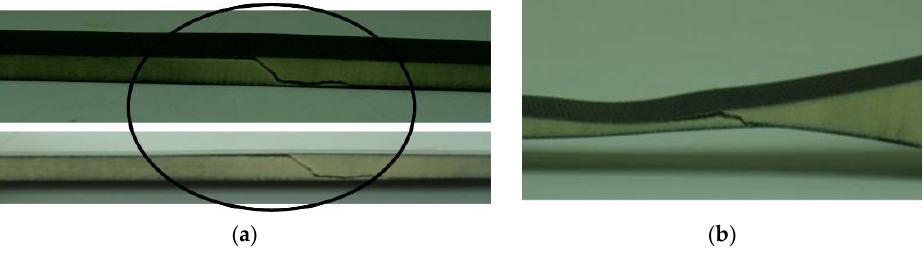
Figure 15. ( a ) Failure found in three-point bending tests; ( b ) failure found in vibration tests.